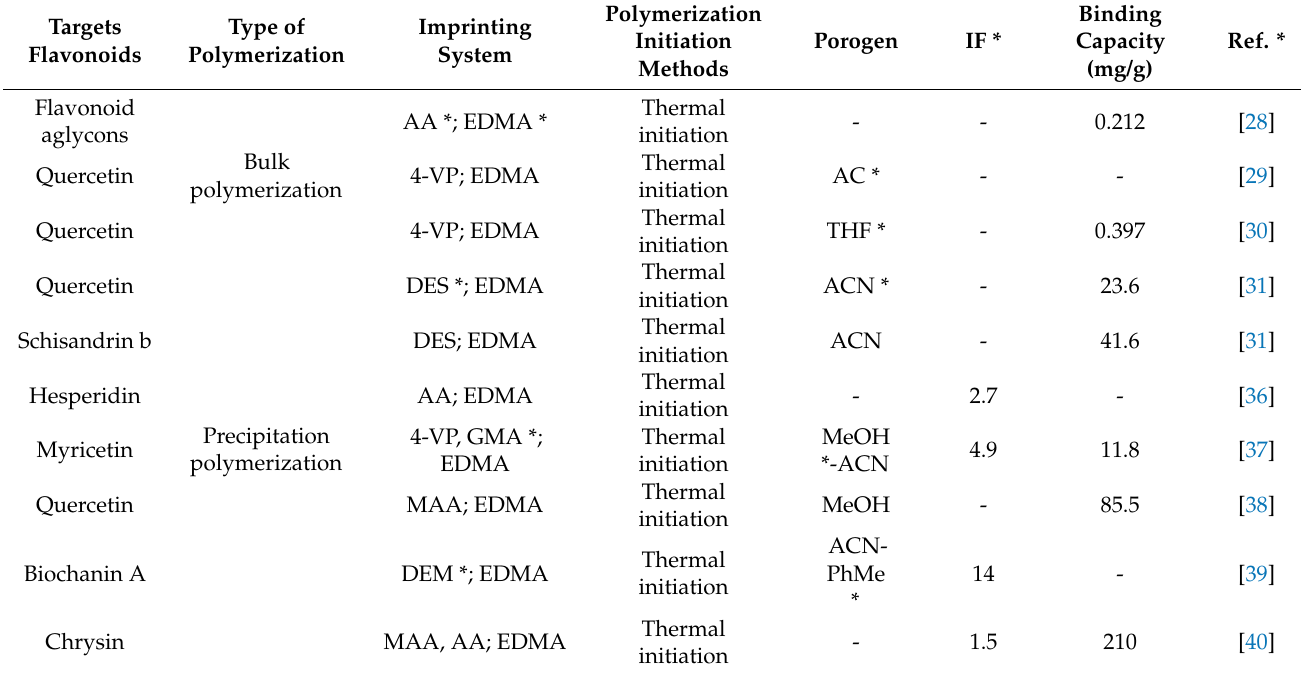
Table 1. Preparation methods of MIPs towards